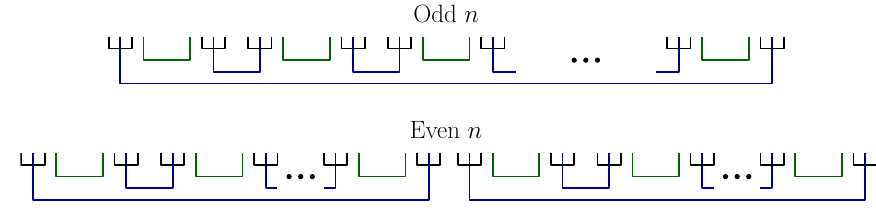
Figure 12 . Rearranging the negativity diagrams results in these diagrams for odd and even n